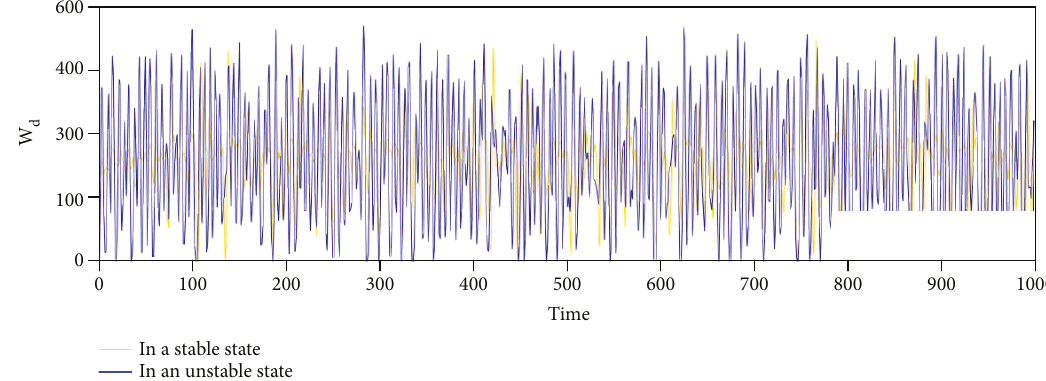
Figure 18: Comparison of tra ffi c volume changes of third-party logistics service providers in a stable state and unstable state under the scenario of random demand obeying uniform distribution.